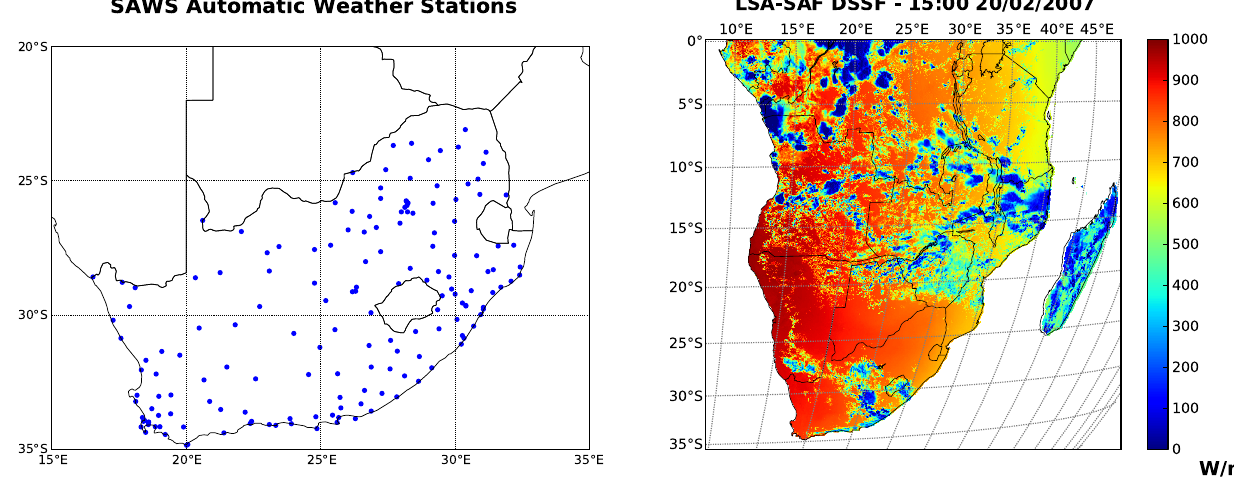
Fig. 2. Example of the LSA-SAF DSSF product for Southern Africa. The data are available at half hour intervals, via the EU- METCast